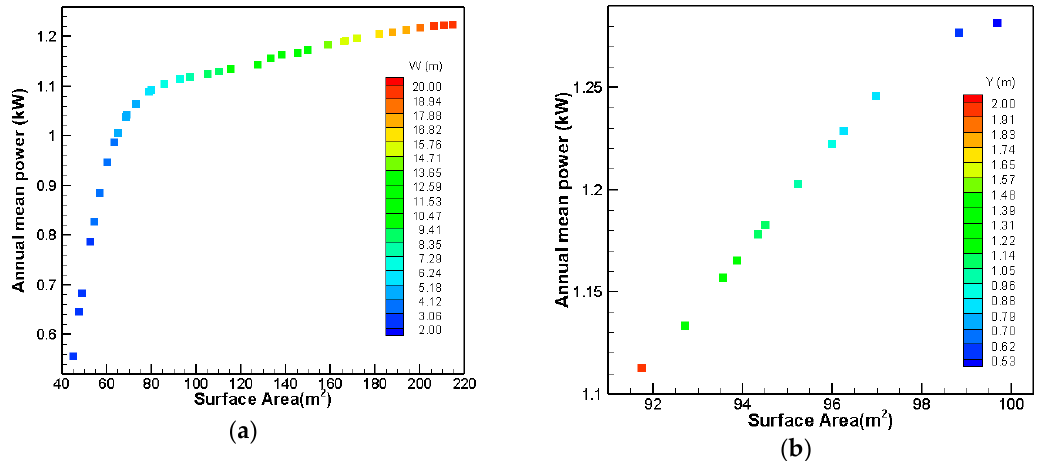
Figure 15. Pareto fronts for ( a ) the width and ( b ) the height of the triangular part of the bottom filleted shape.